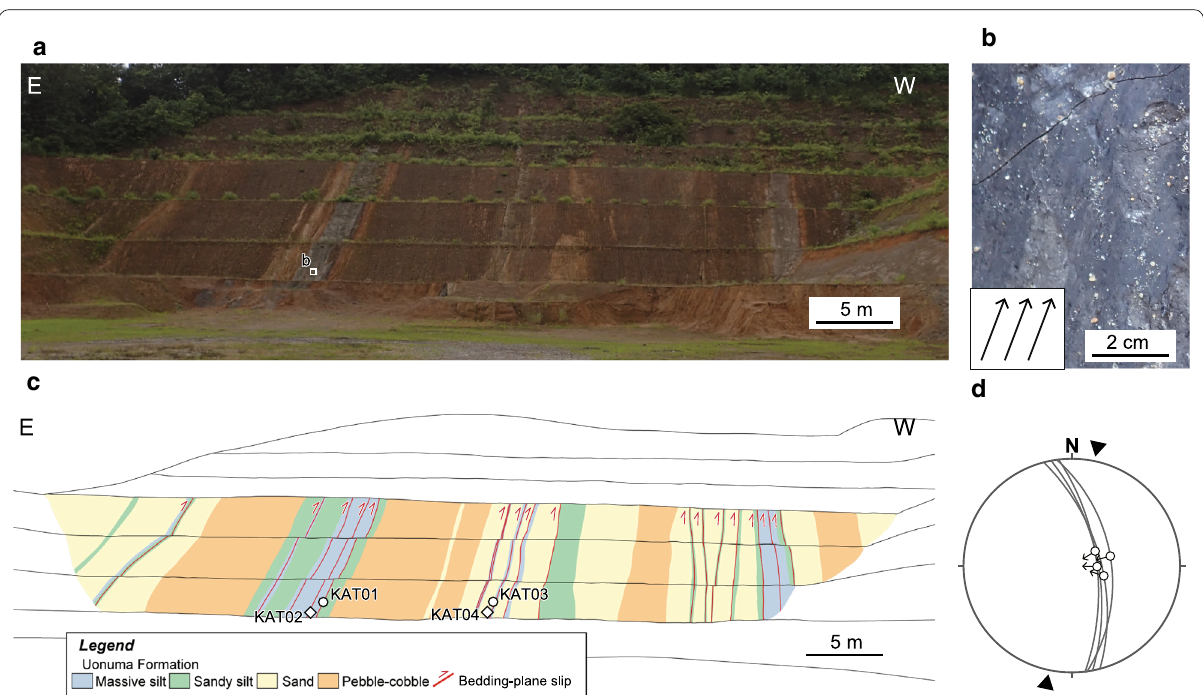
Fig. 2 a Photograph of the outcrop exposure looking south at the Katagai site. The beds of the Uonuma Formation are steeply dipping. b Photograph of the slickenlines on the slip plane. Inset shows the slip direction of the hanging wall. c Sketch of the outcrop shown in a . Red lines show slip planes, flexural-slip faults, and reverse faults. The average spacing of bedding-plane slip surfaces at this site is ~ 4 m. Circles and diamonds indicate sampling sites of fault gouge generated by bedding-plane slip and mudstone, respectively, collected for measurements of the friction coefficient. d Lower hemisphere, equal-angle stereographic projections of the typical bedding-plane slip at the Katagai site. Triangles indicate the trend of the fold axis of the Matto